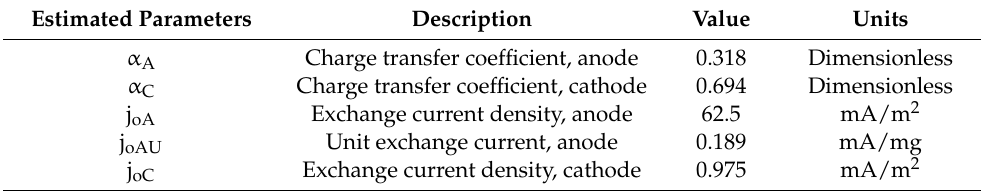
Figure 2. Electrochemical parameters estimation and validation; ( A ) the electrode potential during polarization experiment; ( B , C ) model validation for experimental data from another identical microbial fuel cell (MFC) reactor ( B for U ext , and C for P ext ); and ( D ) comparison of the simulated and experimental U ext during inoculation stage. Table 2. Estimated electrochemical parameters for MFC in this study.